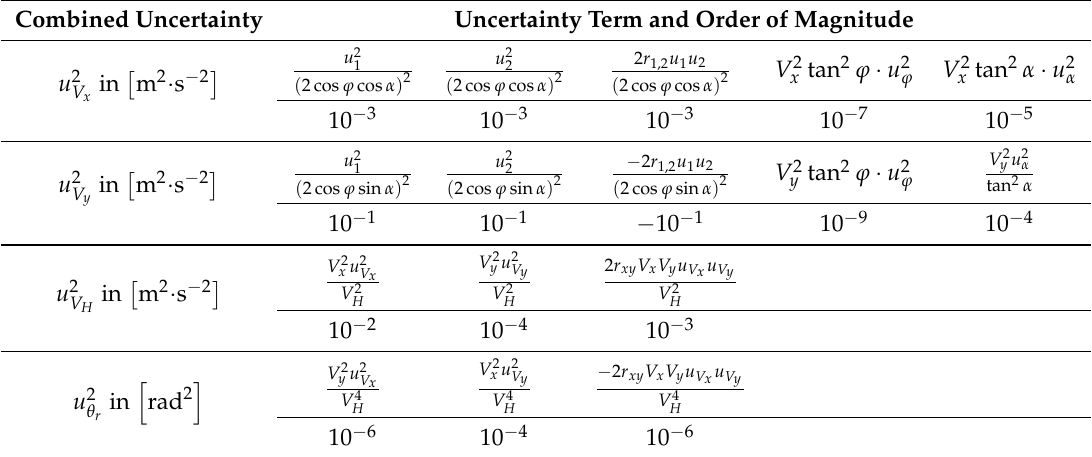
and U θ as a function of V H and θ r ( r 1,2 = 0.9 and r xy = 0.2). H r